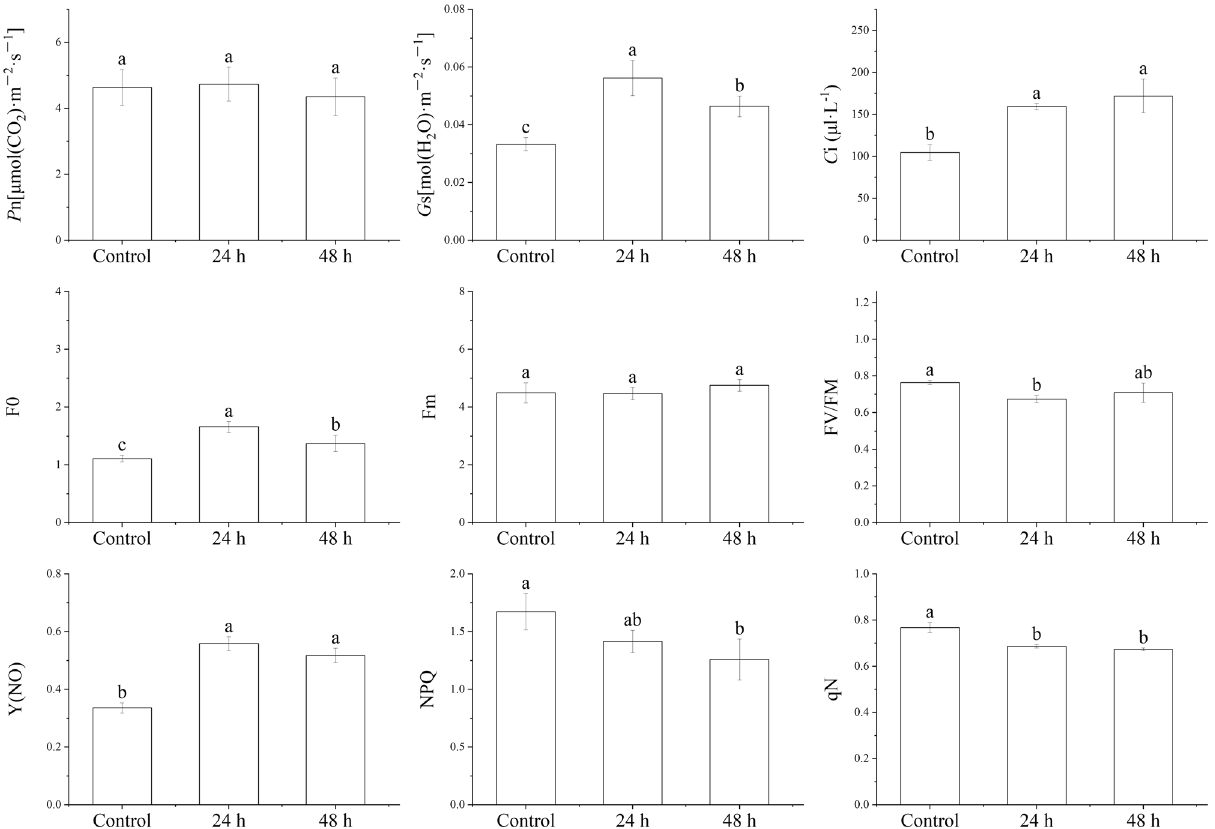
Figure 1. Physiological parameters of pecan under salt stress: photosynthetic rate ( P n); stomatal conductance ( G s); intercellular CO 2 concentration ( C i); initial fluorescence (F0); maximal fluorescence (Fm); maximal photochemical efficiency (Fv/Fm); light-induced nonphotochemical quenching (NPQ); nonregulatory energy dissipation (Y(NO)); photochemical quenching coefficient